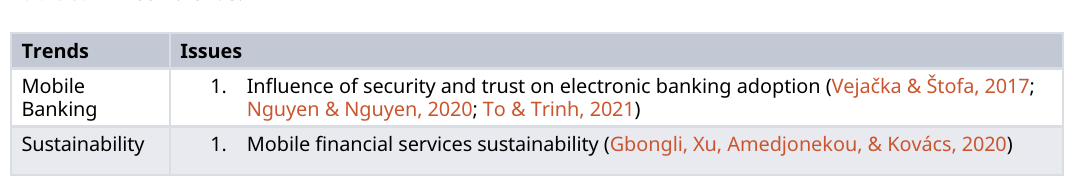
Table 5. FinTech trends.